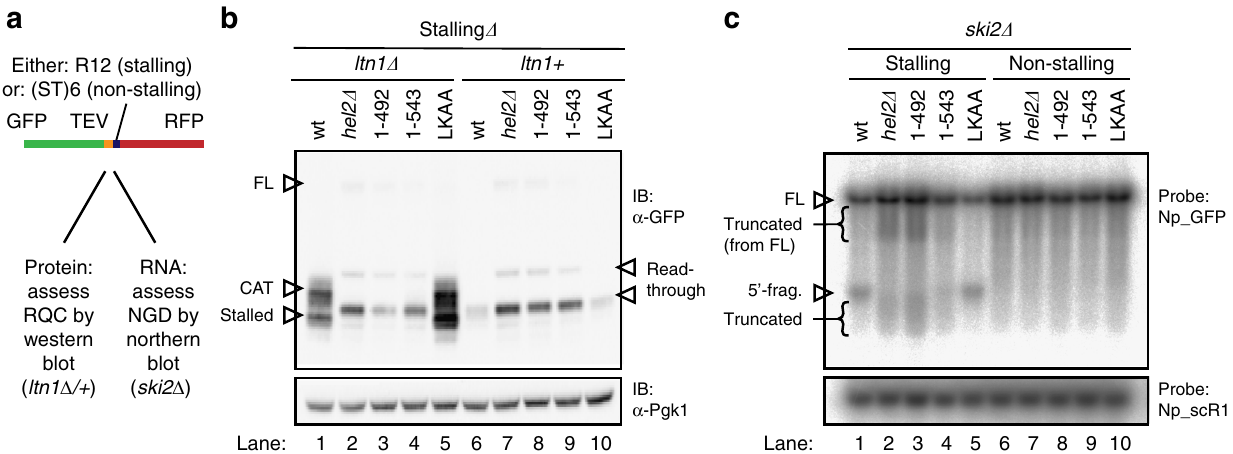
Fig. 7 Assessing functional consequences of HEL2 deletion and mutation using a reporter system for ribosome-associated quality control (RQC) and no-go decay (NGD). a A published 23 reporter system encoding green fl uorescent protein (GFP), TEV protease site, followed by a stalling (R12) or non-stalling ((ST)6) sequence and by red fl uorescent protein to assess RQC and NGD. Scheme adapted from ref. 23 . b Western blot for one of the three biological replicates from independent clones is shown. Data are quanti fi ed in Supplementary Fig. 10. Upper panel: probed with anti-GFP to visualize the reporter. Lower panel: anti-Pgk1 loading control. Migration positions are indicated for the stalled peptide (stalled) and for this peptide modi fi ed by addition of a CAT- tail (CAT). Also indicated are the major product from read-through of the stalling sequence (read-through) and the full-length protein (FL). The region around the FL product is shown in higher contrast in Supplementary Fig. 10a and the region containing stalled and CAT products in Supplementary Fig. 10c. c Northern blot analysis of stalling and non-stalling reporter transcripts in ski2 Δ background using probe Np_GFP and loading control using probe Np_scR1. Autoradiograph for one of the three biological replicates from independent clones is shown. Data are quanti fi ed in Supplementary Fig. 11. Migration positions are indicated for the full-length mRNA (FL), the expected 5 ’ product of mRNA cleavage at the stall (5 ’ fragment/5 ’ -frag.) and for heterogeneous, 5 ’ truncated RNAs